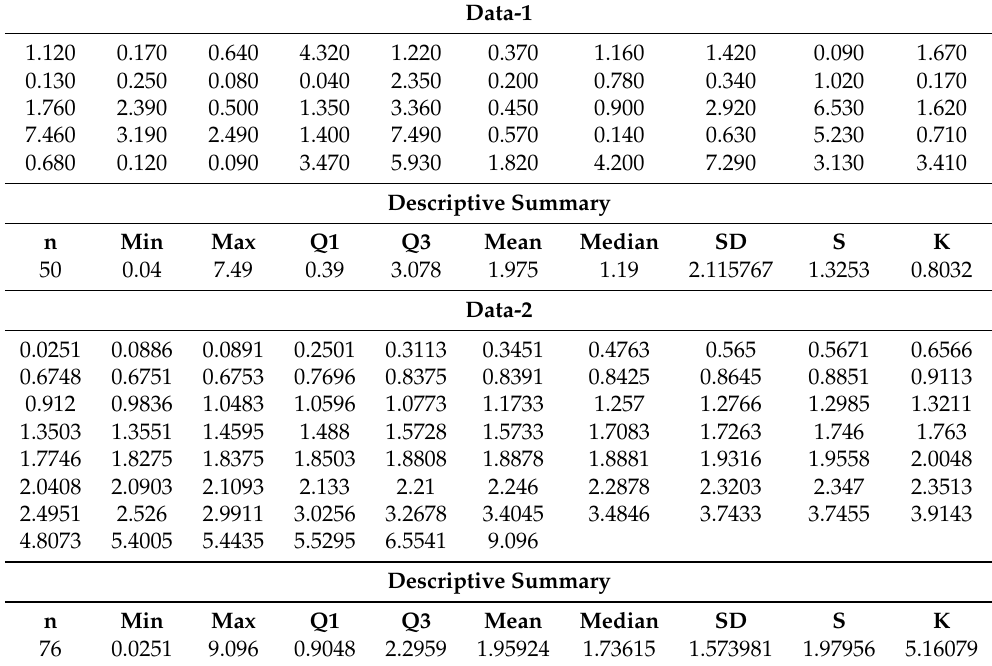
Table 3. Real data along-with descriptive summary.